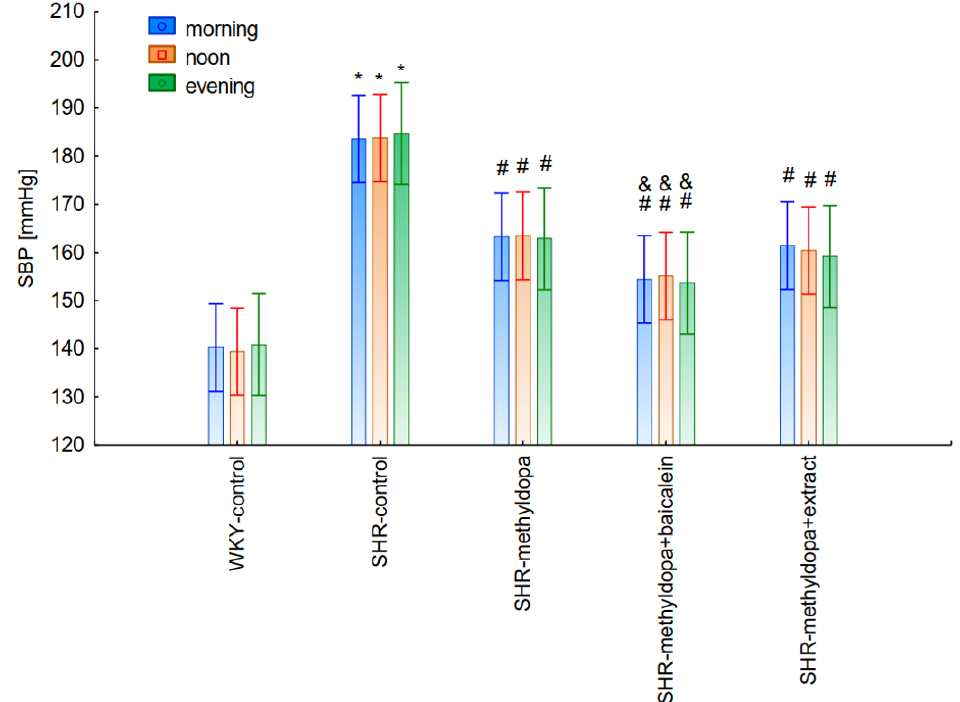
Figure 10. Changes in systolic blood pressure (SBP) after administration of methyldopa and its combination with baicalein and Scutellaria baicalensis root extract with regard to the time of day of administration in SHR pregnant rats. Legend: n = 10, mean ± SEM; * — vs. proper WKY control, p < 0.05; # — vs. proper SHR control, p < 0.05; & — vs. proper SHR-methyldopa, p < 0.05.